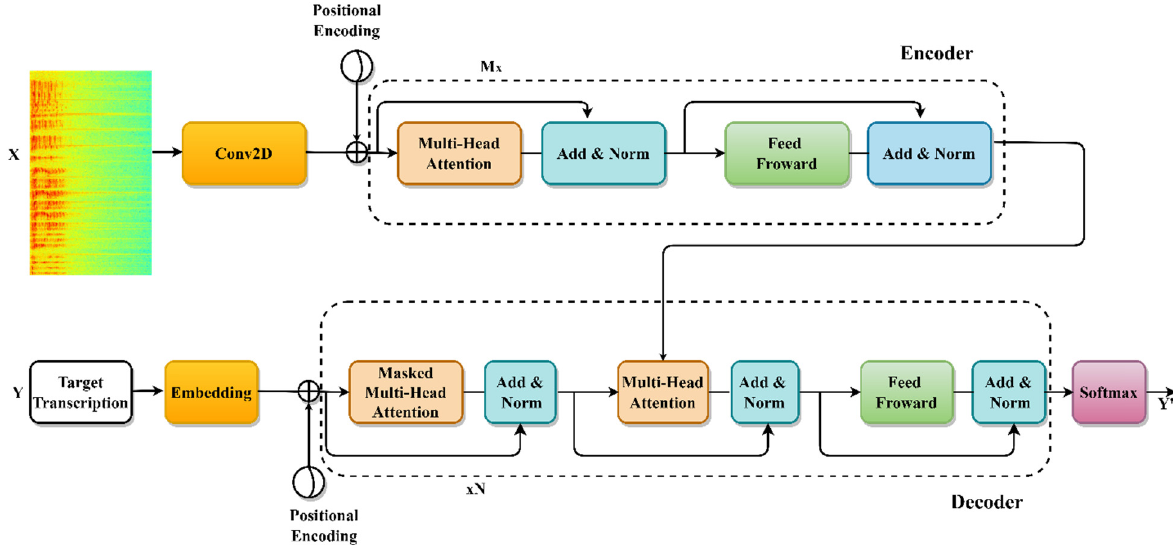
Figure 3. ASR architecture based on E2E transformers. During training, the encoder is fed a sequence of feature frames. In addition, the encoder output is passed to the decoder for the masked target transcription. The decoder provides a prediction of the masked transcription.